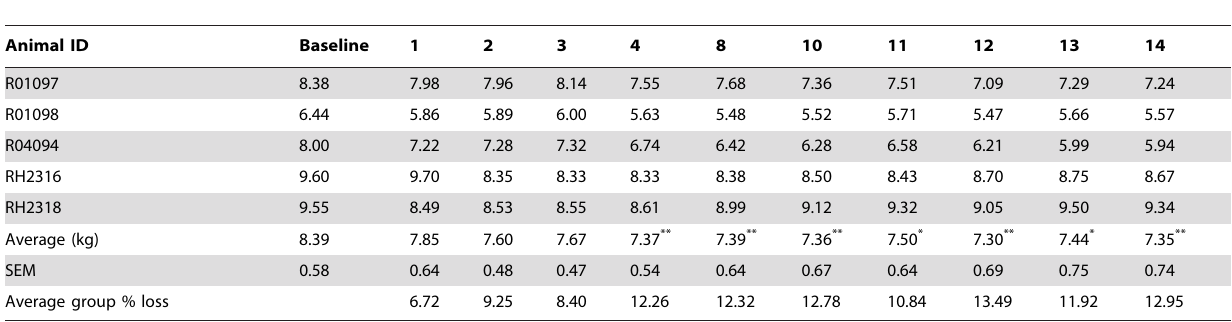
Table 2. Weekly animal weights (kg) and average group % weight loss before and after 6-OHDA dosing.